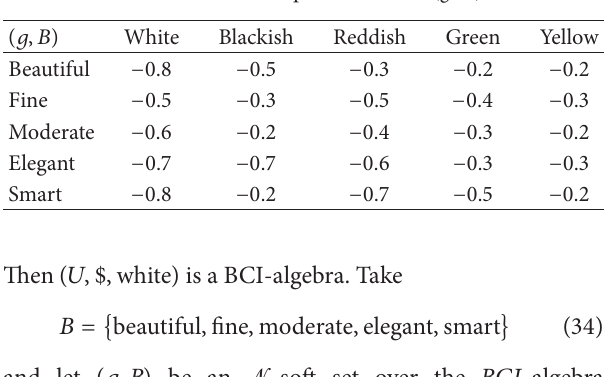
Table 6: Tabular representation of (𝑔,𝐵) .